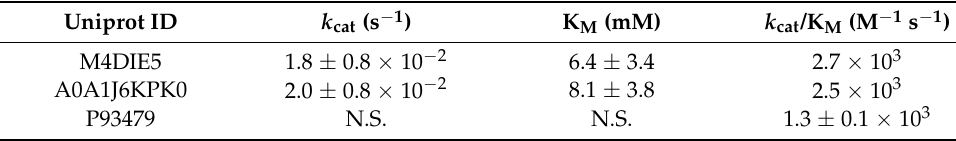
Table 2. Kinetic parameters of cannabinoid synthase